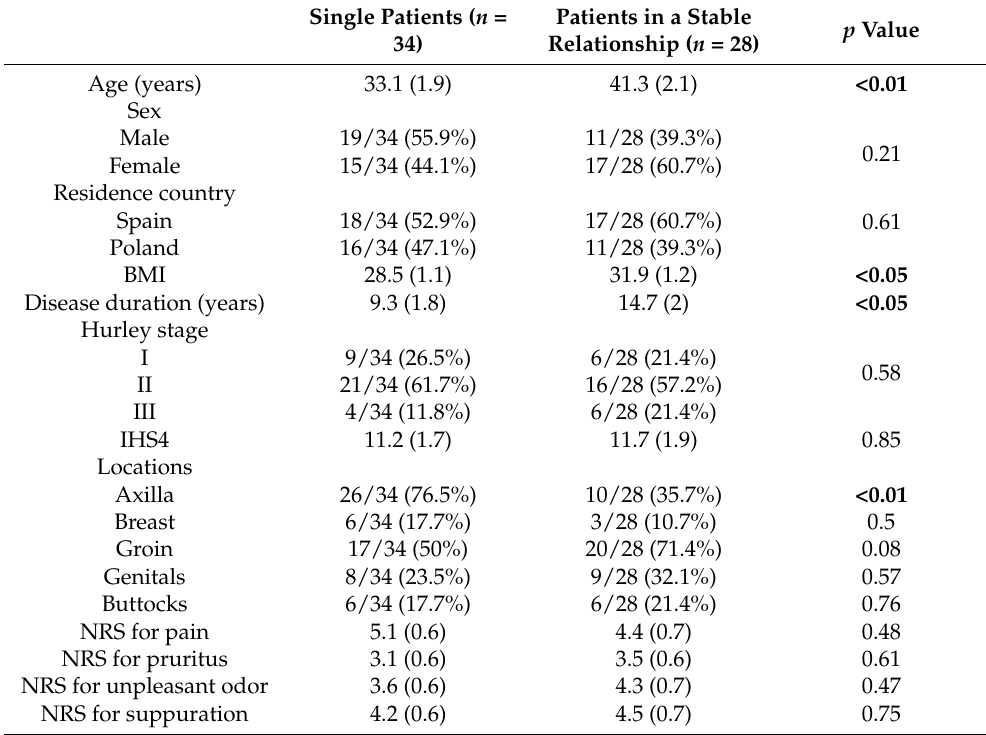
Table 1. Sociodemographic and disease characteristics of HS